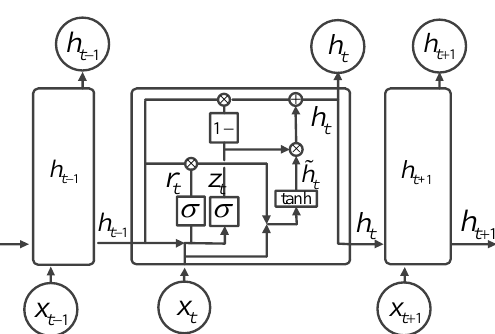
h is the output of the previous 1 t h is the output of the current t